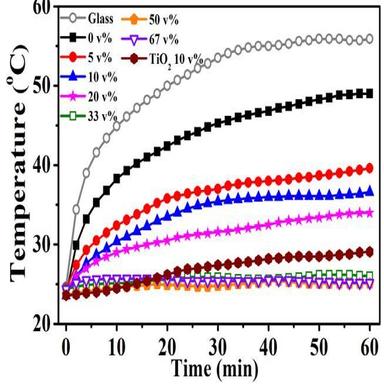
Actual heating curve of PVC films, PVC porous films and PVC/TiO2 composite films tested indoors.